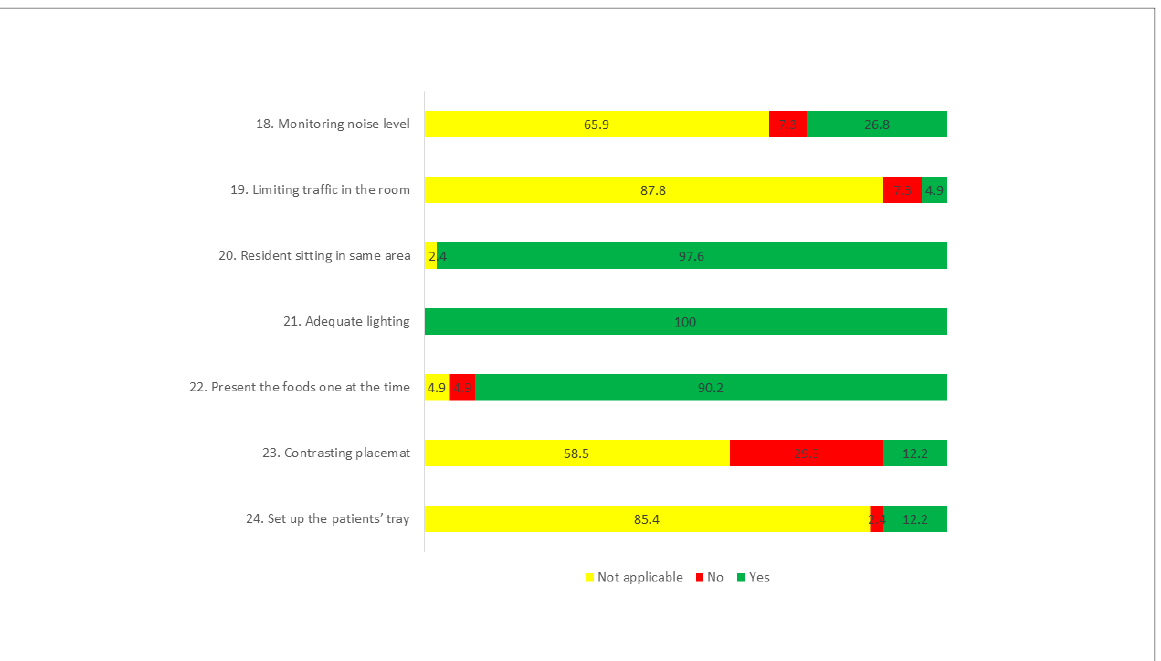
Figure 2. Actions performed (%)—Caregiver dimension.